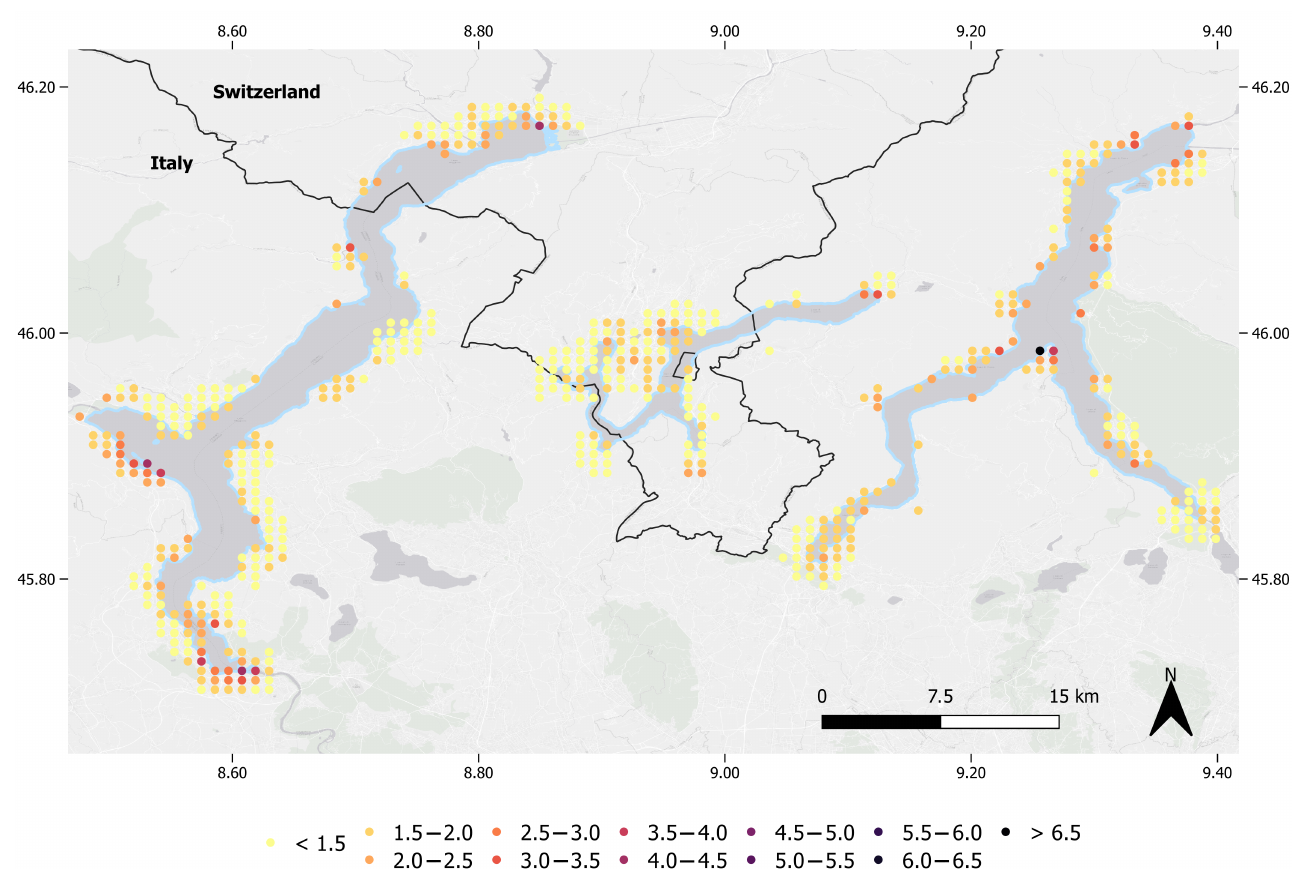
Figure 6. Map of the ratios between the 90th percentile of the time series of Facebook users’ counts and the baseline population value. The ratio is computed at each location (Bing tile centre) in the dataset. Missing locations from the Bing tiles grid correspond to tiles with users’ counts lower than 10 that were not available in the Facebook Population Maps